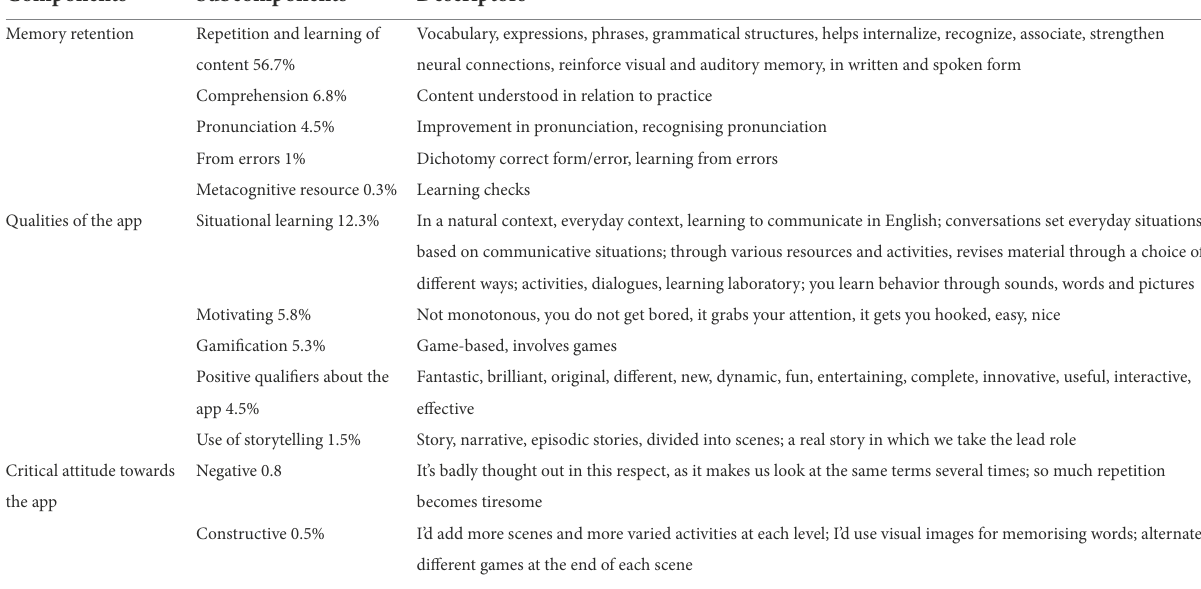
TABLE 3 Improving memorisation of